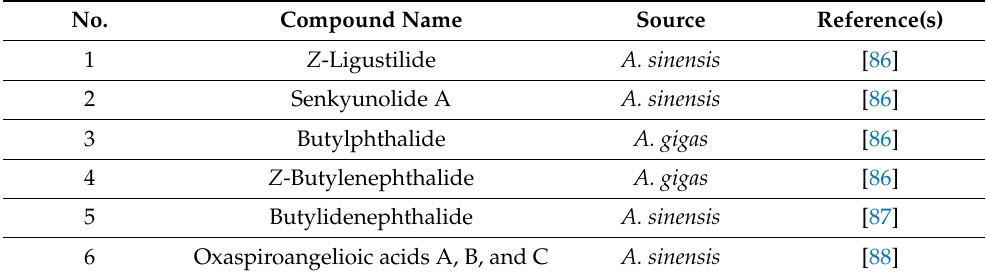
Table 4. Phthalides isolated from genus Angelica